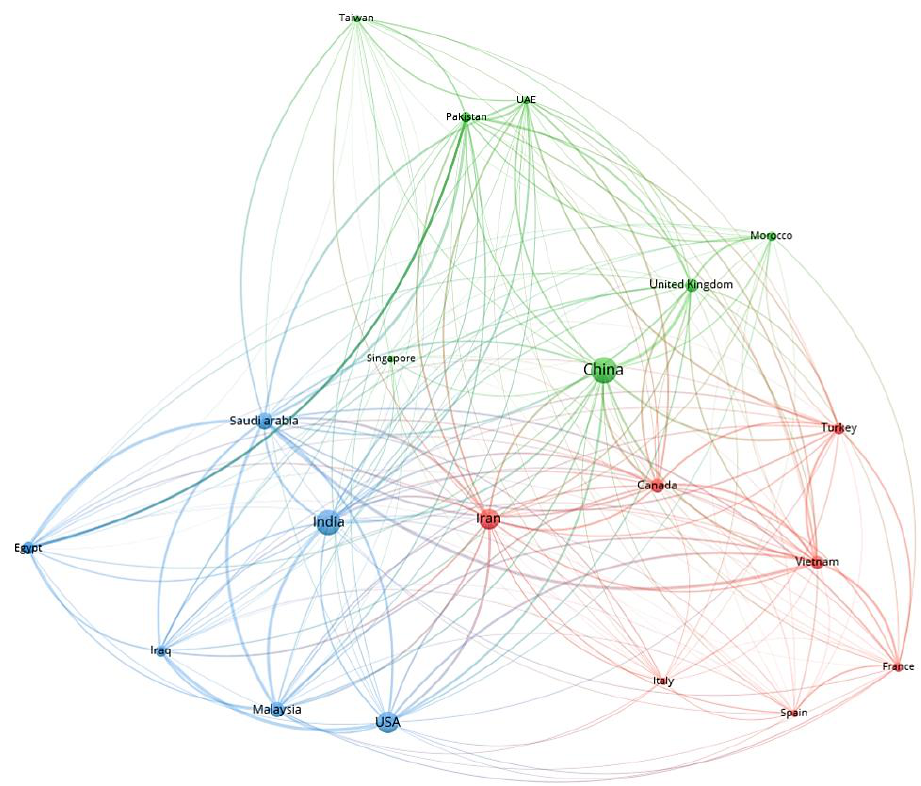
Figure 5. Collaboration between countries.